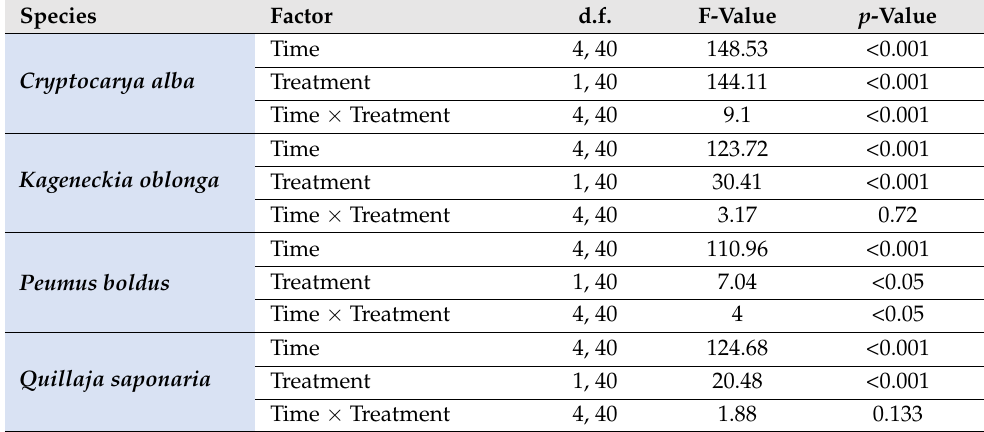
Table 1. Results of two-way repeated measures ANOVA for the survival for the four tree species. Main factors: Time, AMF treatments, and their interaction. Degrees of freedom (d.f.), F-values, and p -values are